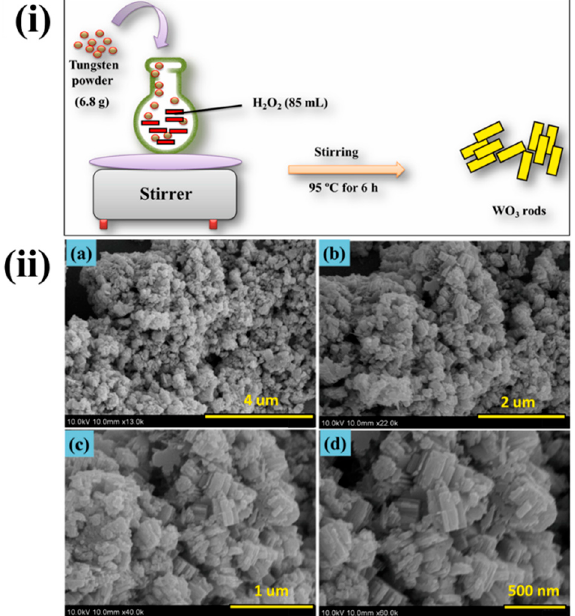
Figure 13. Schematic representation of the synthesis of WO 3 rods. ( i ) SEM image of WO 3 rods at different magnifications (a–d) ( ii ) [121].